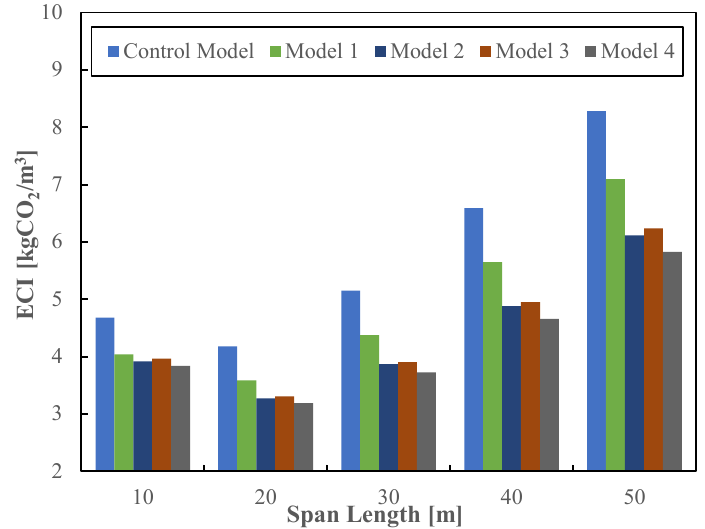
Figure 3. Average ECI variation with span length for different